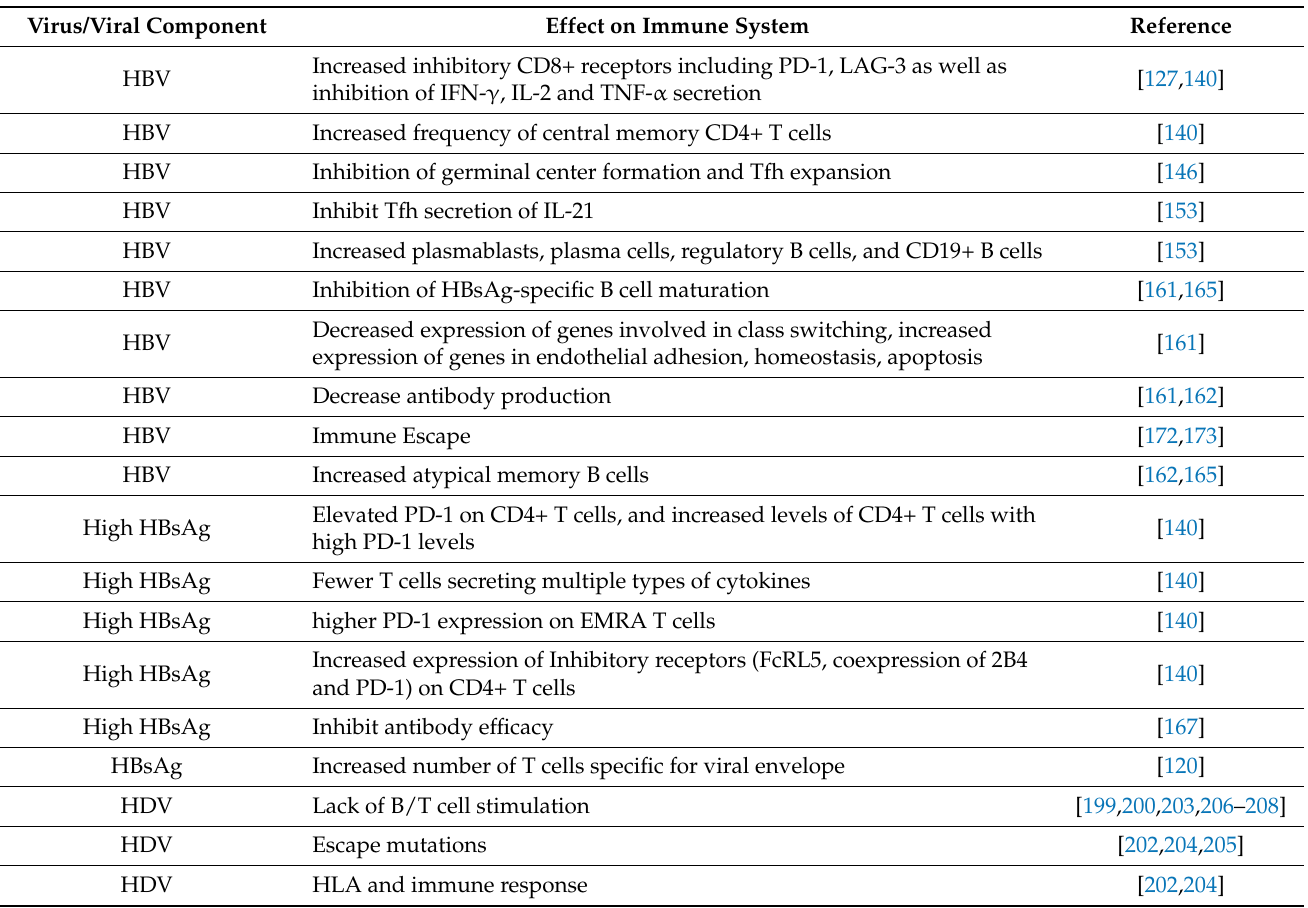
Table 2. Summary of Interactions between the immune system and HBV/HDV. Virus/Viral Component Effect on Immune